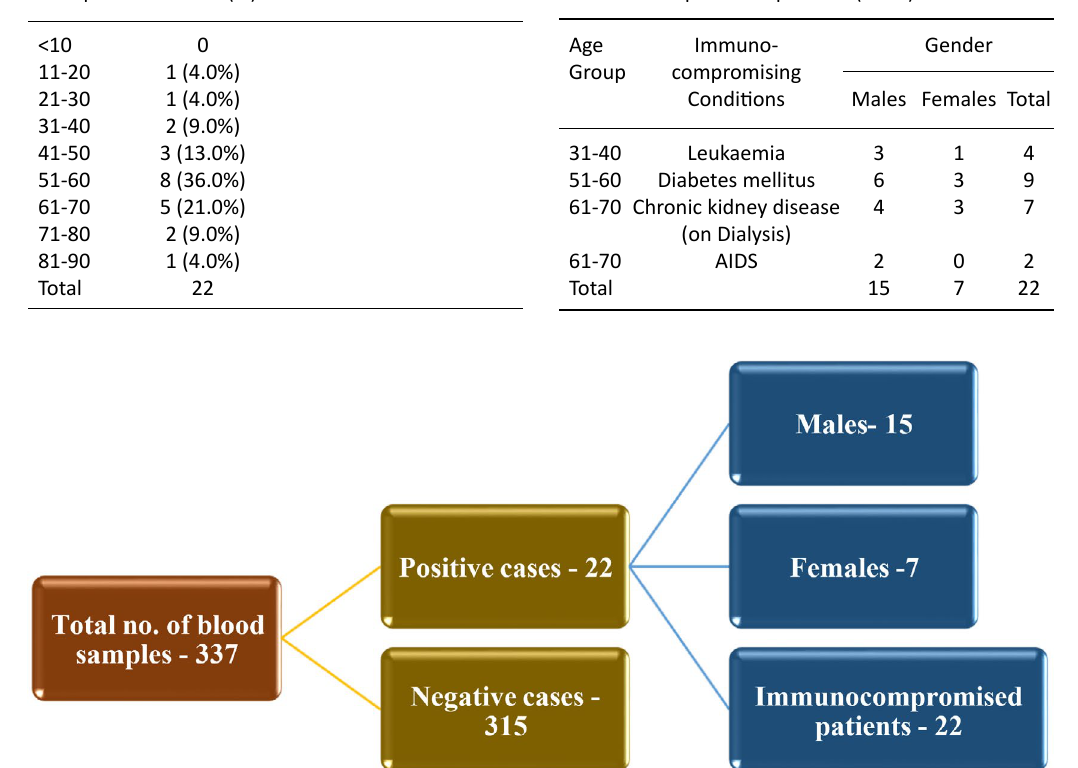
Table 2. Distribution of age and gender among